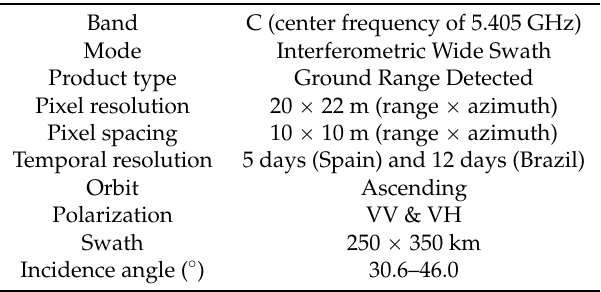
Table 1. Main characteristics of Sentinel-1A L1C images [50].